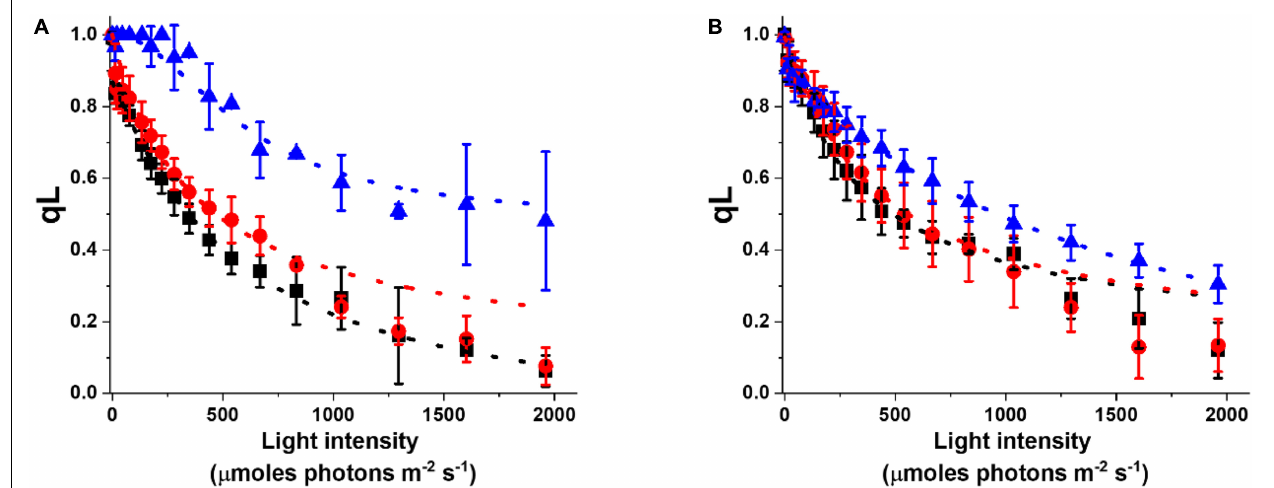
FIGURE 5 | Photochemical activity of Nannochloropsis cells in different lab-scale conditions. Photochemical activity is expressed as the fluorescence parameter qL as a function of irradiance. Data were collected for cells grown in some of the conditions listed in Supplementary Table 1 . Data refer to lab-scale cultures grown diluted ( < 25 × 10 6 cells/ml) in flasks (A) and dense ( > 50 × 10 6 cells/ml) in glass tubes with air bubbling (B) , and acclimated to 10 (black squares), 100 (red dots), and 1,000 (blue triangles) µ moles of photons m − 2 s − 1 .